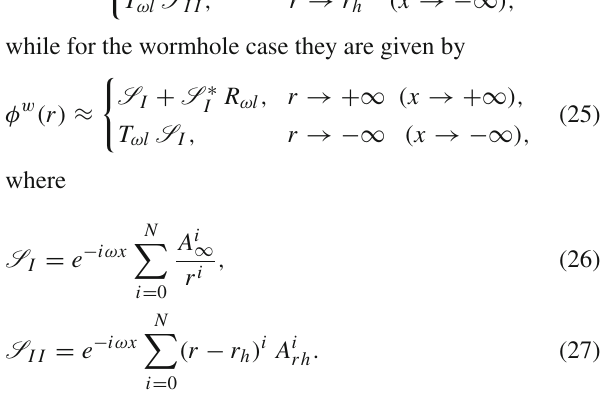
Fig. 2 The glory parameters for the Simpson–Visser black hole in termsoftheinterpolationparameter a / M presentinthelineelement(1). We note that b g and b 2 g | db / d χ | χ = π are monotonically increasing func- tionsoftheinterpolationparameter a ,while r c decreasesmonotonically with a . The critical impact parameter b c remains constant for the whole range of the interpolation parameter of the black hole